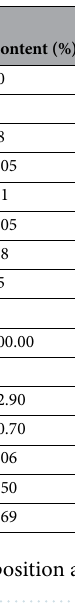
N t is the final number of channel catfish, N 0 is the initial number, t is the feeding days (d), W t is the final body weight (g), W 0 is the initial body weight (g), W f is the feed intake (g), Ln is the natural logarithm, W h is the fish liver weight (g), W v is the fish viscera weight (g), W is the fish body weight (g), and L is the length of fish (cm).